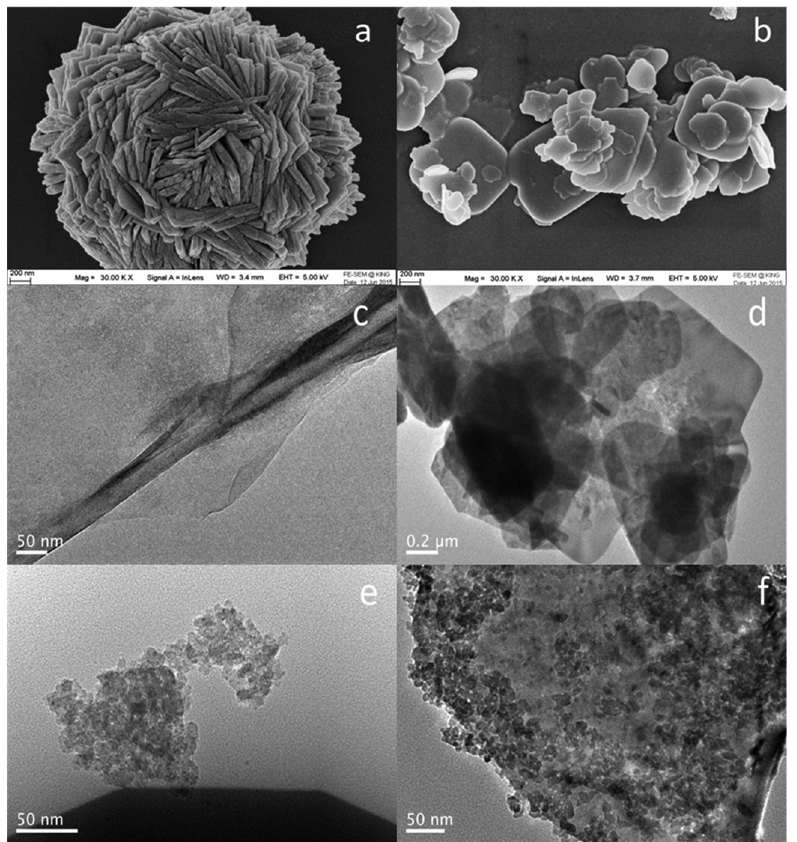
Figure 9: SEM images of ( a ) pure BiOCl and ( b ) BiOCl - ZnCr - Ex and TEM images of ( c ) ZnCr - Ex, ( d ) BiOCl - ZnCr - Ex, ( e ) pure TiO 2 , and ( f ) TiO - BiOCl - ZnCr - Ex - 4. Reproduced with permission from ref. [ 99 ] ; copyright ( 2017 ) , 2